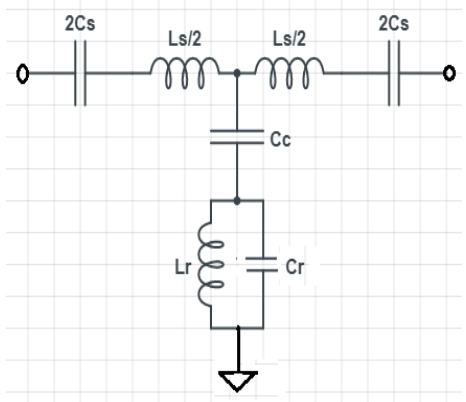
Figure 8. Equivalent circuit of HMSIW BPF with CSRR.